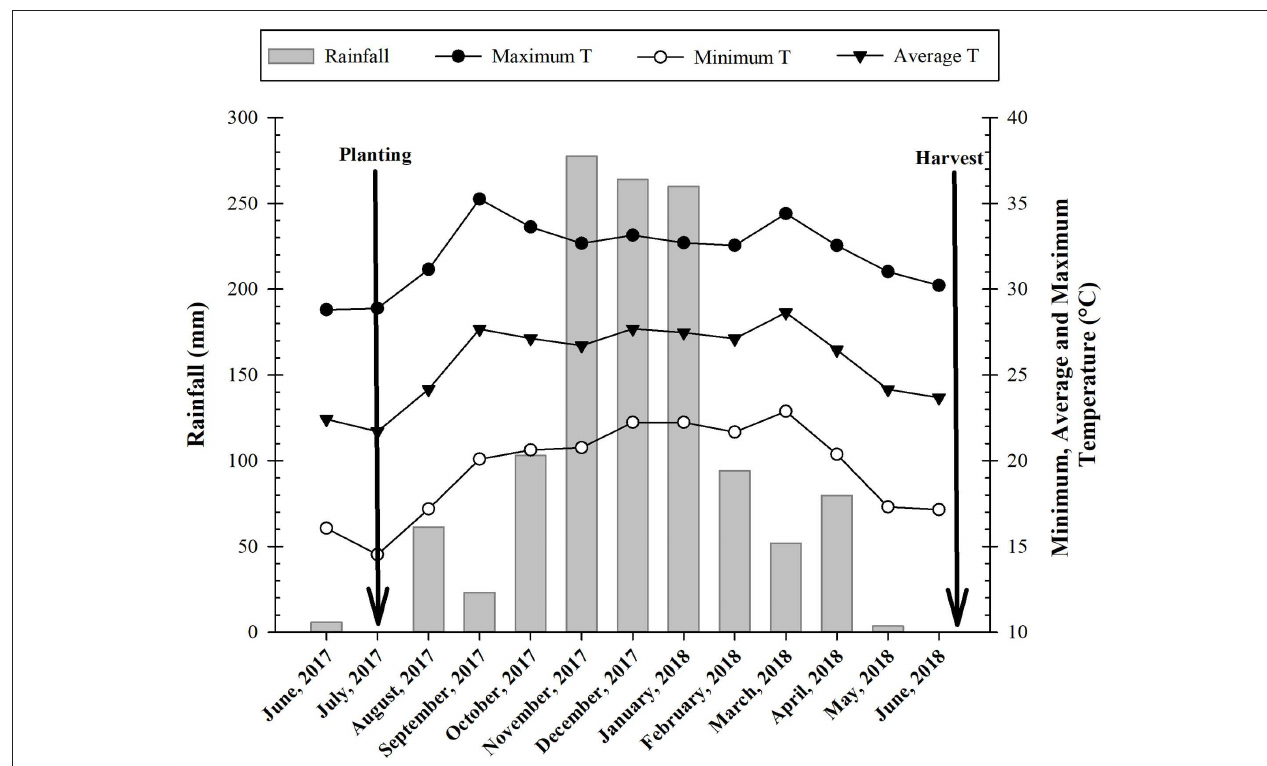
FIGURE 1 | Monthly averages of precipitation (mm), maximum, average, and minimum temperatures recorded during the period in which the experiment was conducted. Ilha Solteira, state of São Paulo, Brazil, 2017/2018.